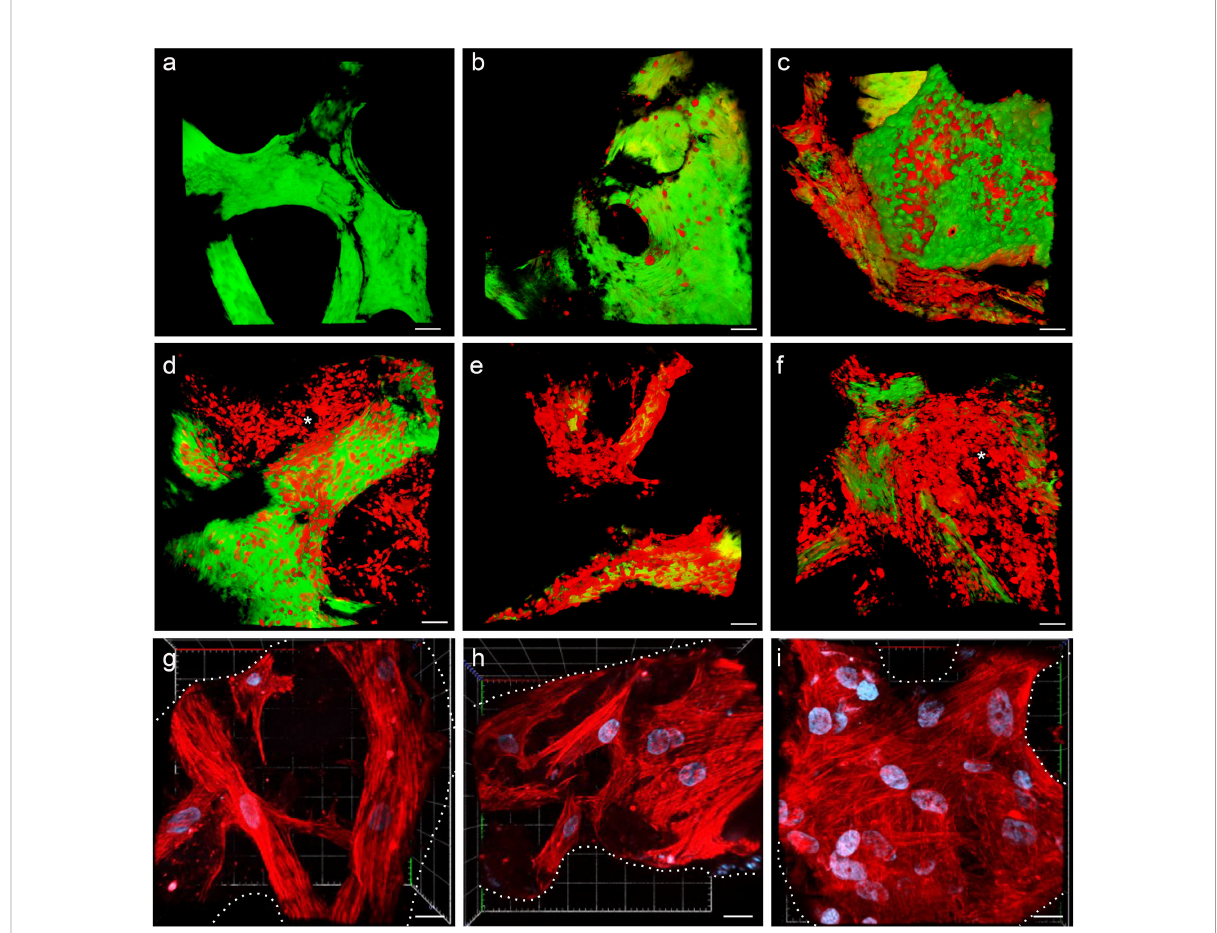
FIGURE 3 (A – F) Multiphoton microscopy 3D reconstruction of HS-5 mCherry + cells grown in the scaffold. (A) Decellularized scaffold (auto fl uorescence). (B) 24 h after direct seeding. (C) 24 h after PDMS device seeding. The following images represent the model after 8 (D) , 14 (E) , and 19 (F) days of incubation. * indicated MSC forming cellular niches fi lling the trabecular bone area. Scale bar: 50 m m. Images acquired with the Multiphoton Galvo System (Scienti fi ca, UK) and analyzed with the ImageJ software. (G – I) Confocal microscopy 3D reconstruction of BM-MSC grown in the scaffold. Images acquired with a Zeiss confocal microscope after 7 (G) , 12 (H) , and 15 (I) days of incubation and analyzed with the Zeiss ZEN 3.2 blue edition program, and 3D reconstruction was performed by the 3D viewer plugin of Fiji. Blue: DAPI; red: phalloidin. Scale bar: 20 m m.